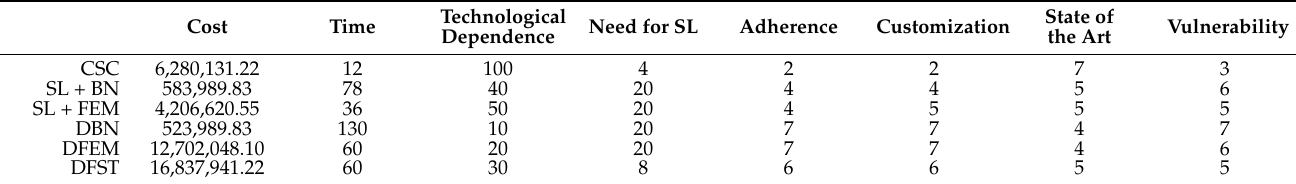
Table 1. Decision Matrix.